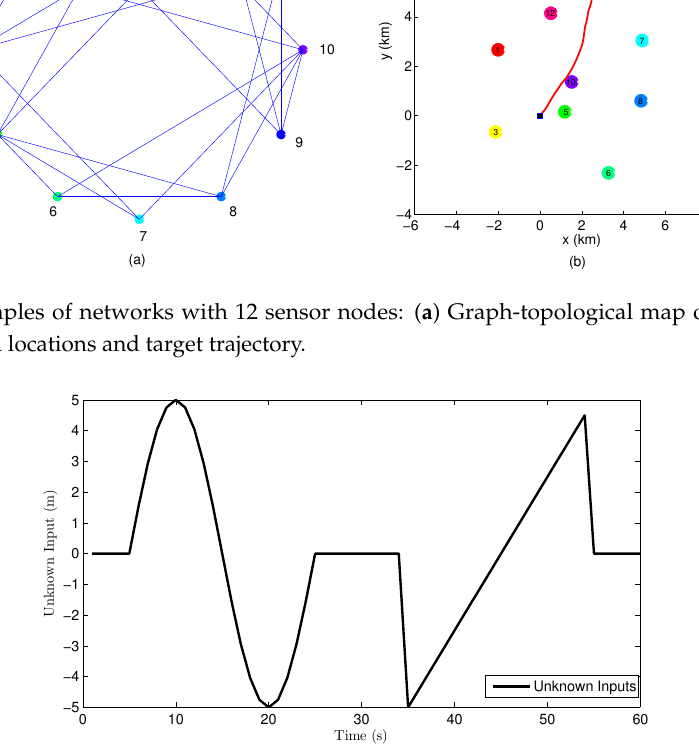
Figure 5. Real unknown input in the multi-sensor system.